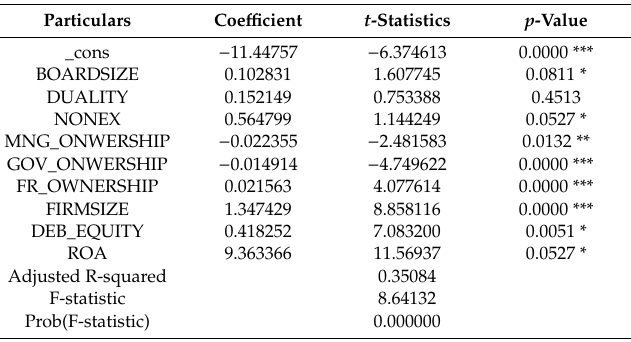
Table 4. Regression results (Robust fixed e ff